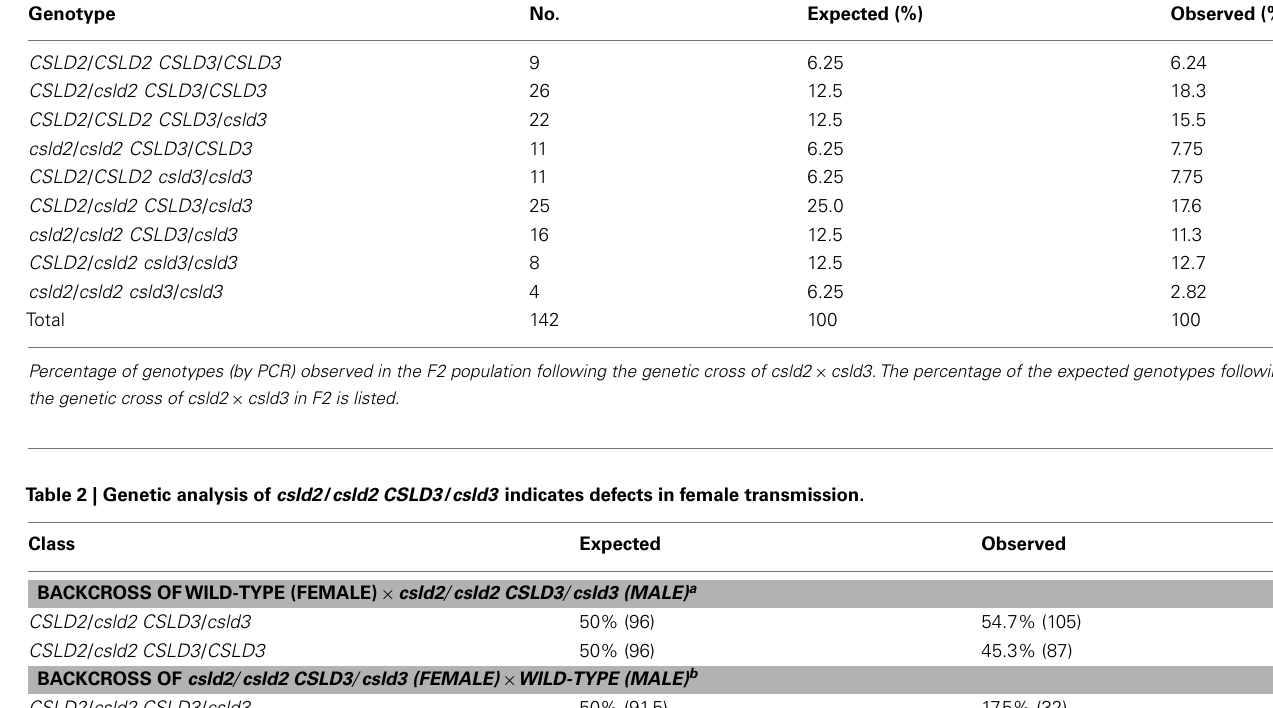
Table 1 | Summary of the infertility of csld2 and csld3 mutant progeny. Genotype No.